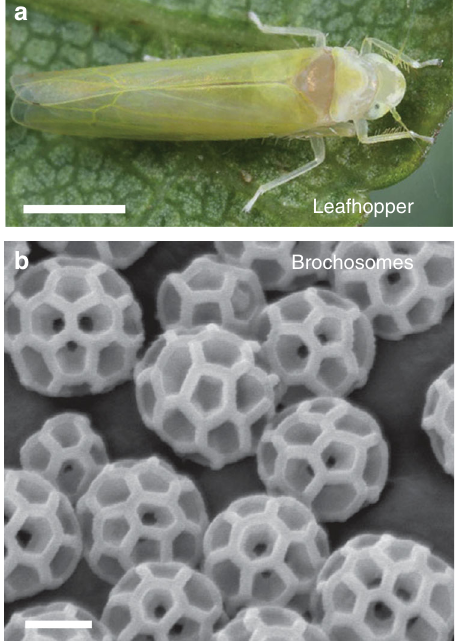
Fig. 1 Leafhopper and its brochosomes. a Optical image of a leafhopper, Alnetoidia alneti (Dahlbom), and b an electron micrograph showing its brochosomes. Both images are reprinted from ref. 19 , by permission of the Royal Society. Scale bars, 1 mm (leafhopper) and 200 nm